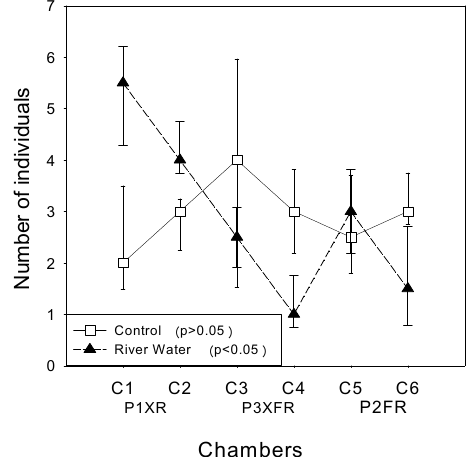
Figure 4. Distributions of A. bimaculatus (twospot Astyanax ) fish in the control assay (using well water) and in the assay with exposure to river water (C1 and C2 = P1XR; C3 and C4 = P3XFR; C5 and C6 = P2FR). Table 2. Percentage distributions of A. bimaculatus (twospot Astyanax ) according to chamber and treatment, using the river water samples from the P1XR, P2FR, and P3XFR